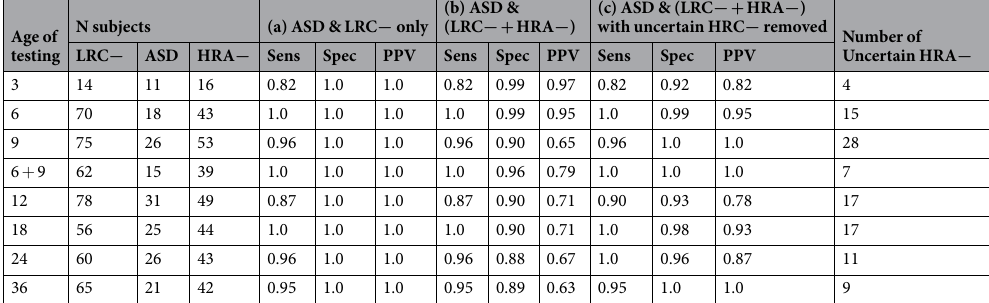
Table 5. Predictive classification of 36-month outcomes based on EEG feature classification. Sens = Sensitivity, Spec = Specificity, PPV = Positive Predictive Value. The age represents the age at which EEG was taken. The ‘6 + 9’ row was derived by combining all nonlinear features from measurements at 6 and 9 months from participants who had both visits. Columns (a) are results from classifying low risk controls without autism (LRC − ) and ASD infants. (b) results from classifying the outcome of all participants. The last set of results, (c) was obtained by computing simulated CSS scores based on distance from the model hyperplane, as illustrated in Fig. 2, then removing participant scores that fell in the 3.5 to 4.5 range. These were labeled as “uncertain”. Sensitivity, specificity, and PPV were then computed for all of the remaining